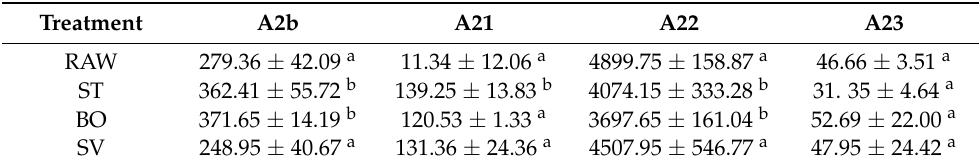
Table 1. LF-NMR parameters of peak areas (A) of squid ( Symplectoteuthis oualaniensis ) mantle muscle samples before and after treatment of RAW, ST, BO, and SV. Treatment